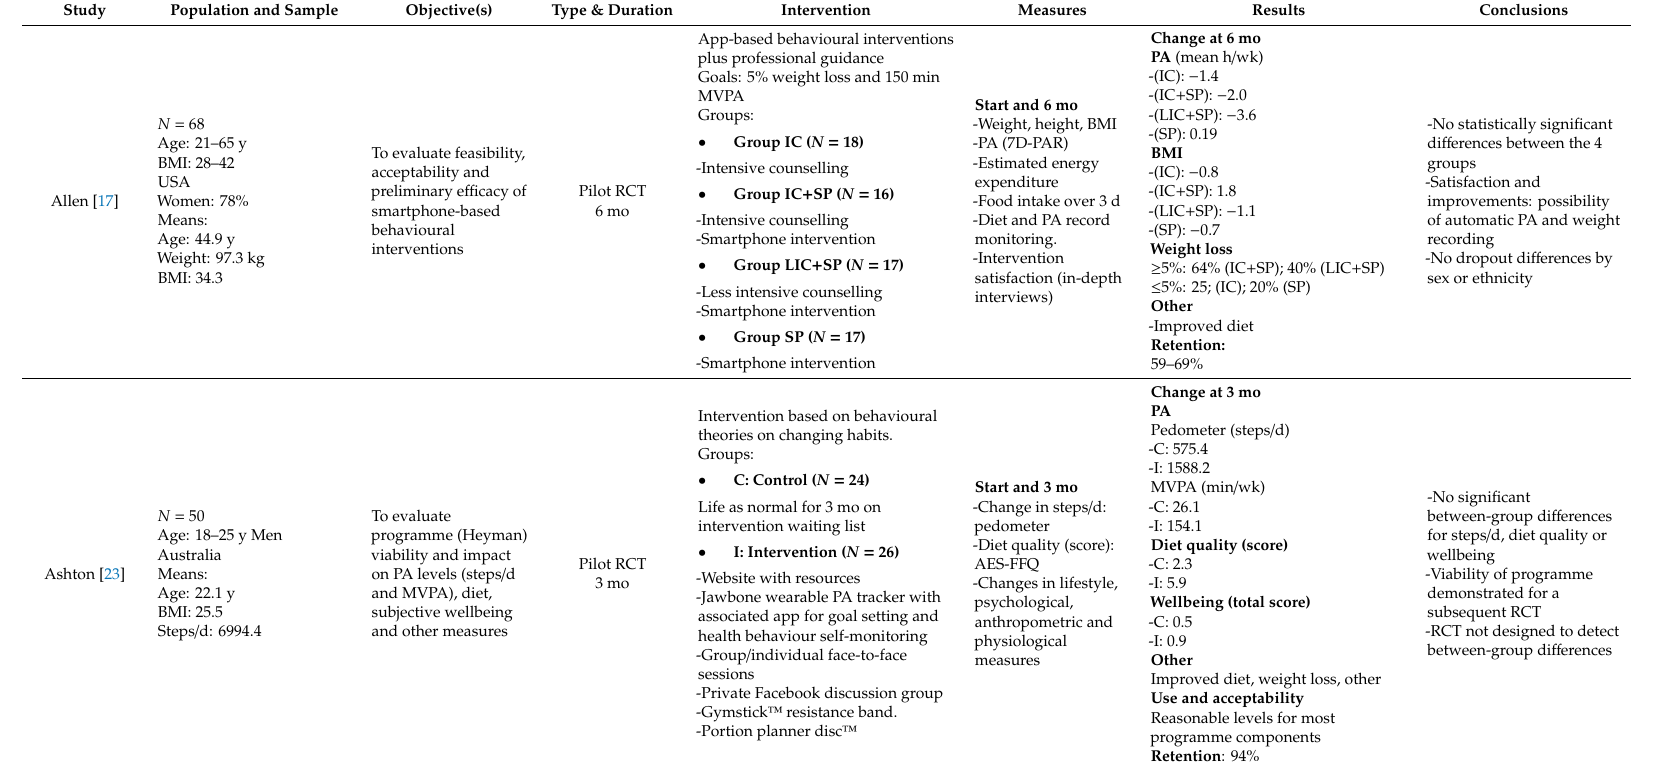
Table 2. Details of the 14 reviewed